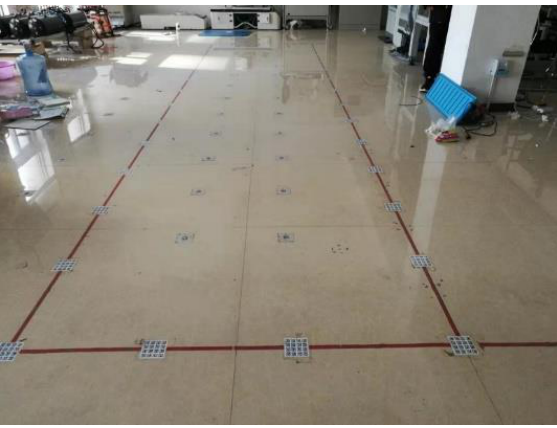
Figure 14. Tag labeling experiment site.